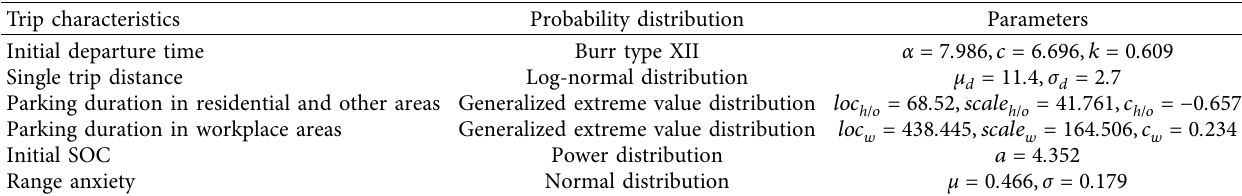
Table 3: Probability distribution